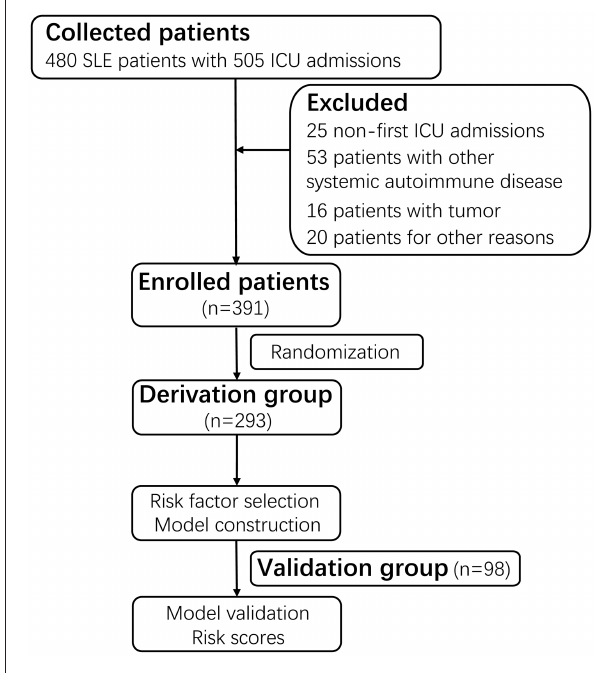
FIGURE 1 | Flow diagram of the study. A total of 480 SLE patients with a combined 505 ICU admissions were screened. After excluding 25 non-first admissions, 53 patients with antiphospholipid syndrome or other systemic autoimmune disease, 16 patients with tumors, 20 patients admitted to the ICU for reasons unrelated with SLE, a total of 391 patients with the first ICU admission were enrolled. Based on the random number table, the 391 patients were divided into two mutually exclusive groups named derivation group ( n = 293, 74.9%) and validation group ( n = 98, 25.1%). The derivation group was used to identify prognostic factors for in-ICU survival, and the validation group was used for evaluation. SLE, systemic lupus erythematosus; ICU, intensive care